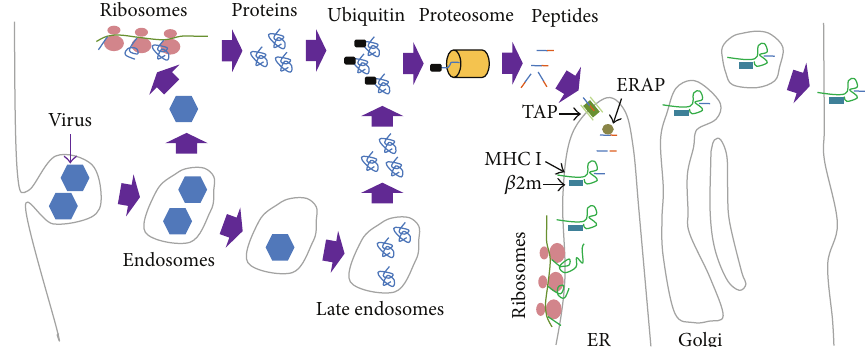
Figure 1: MHC I antigen presentation pathway. In this diagram the peptides derive from viruses that are taken into the cell by endocytosis. However, this could be any protein. The virus escapes the endosomes into the cytoplasm where it is transcribed and translated (ribosomes at the top). Some proteins also escape later into the cytoplasm. As these proteins become dysfunctional, they are labeled with ubiquitin (black rectangle) and transported to the proteosome in which the proteins are degraded into small peptides. These peptides translocated into the endoplasmic reticulum (ER) by the transporter associated with antigen processing (TAP). They are cleaved further in the ER by the ER associated peptidase (ERAP). MHC I is synthesized in the ER and dimerizes with beta-2-microglobulin ( 𝛽 2m). MHC I binds to small peptides in the ER and the MHC I-peptide complexes are transported to the cell surface in exocytic vesicles.